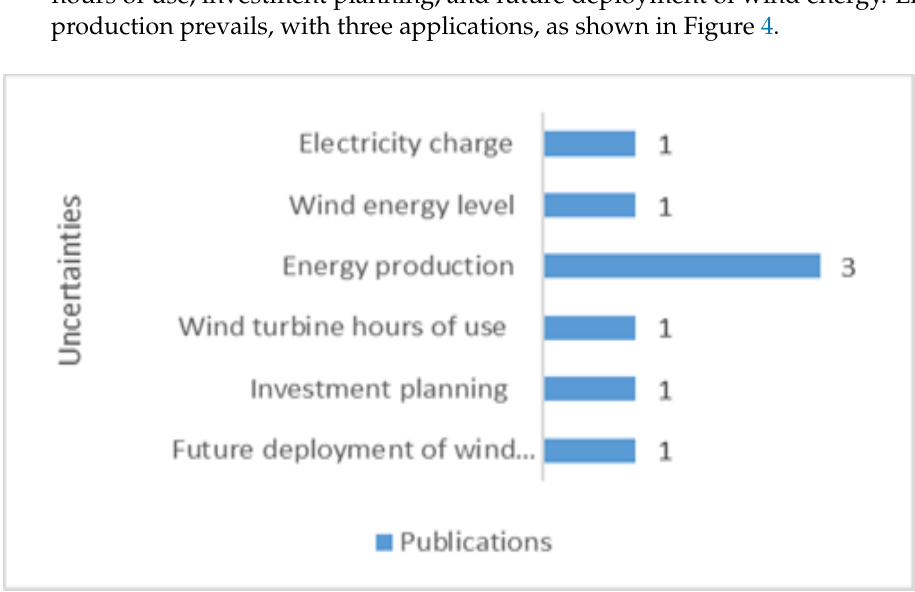
Figure 4. Power generation.